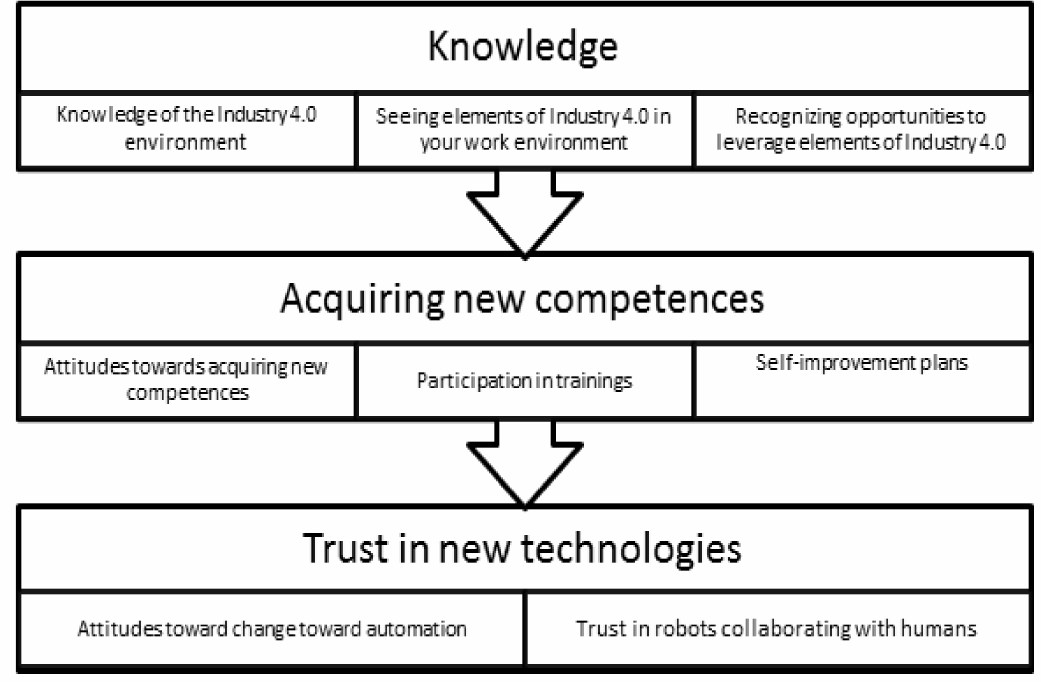
Figure 2. Research model. Source: the